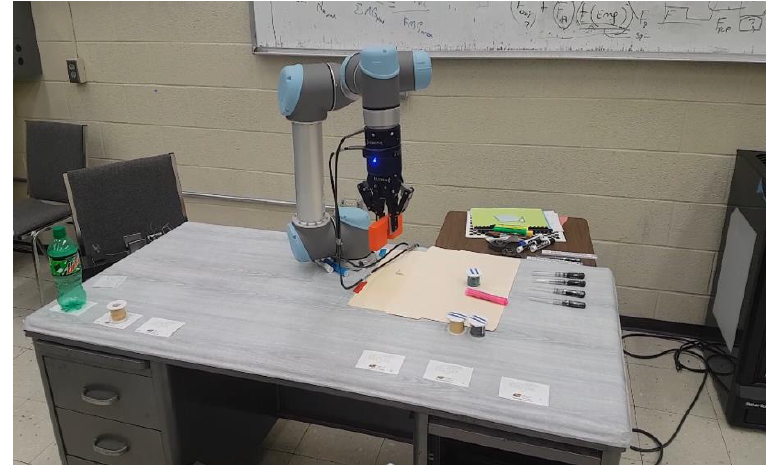
Figure 8. Experimental setup showing the UR5 and three objects. Algorithm 1: ODCA for a robot pick and place operation operating on